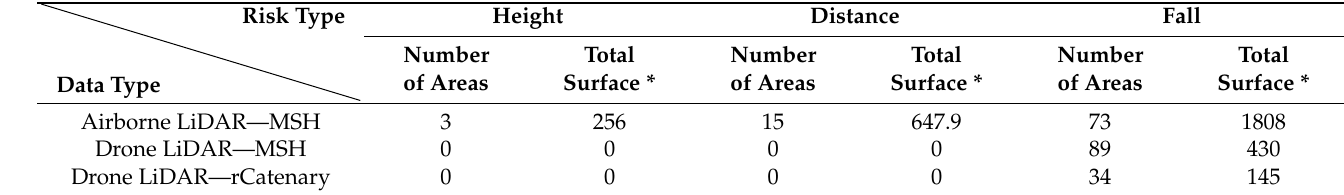
Table 3. Risk analysis and comparison corresponding to each type of data and the three different geometric risks. * Surface units in m 2 . MSH refers to theoretical catenary estimated based on the maximum sag hypothesis. rCatenary refers to the real catenary computed from the geometry extracted from the point clouds using drone LiDAR